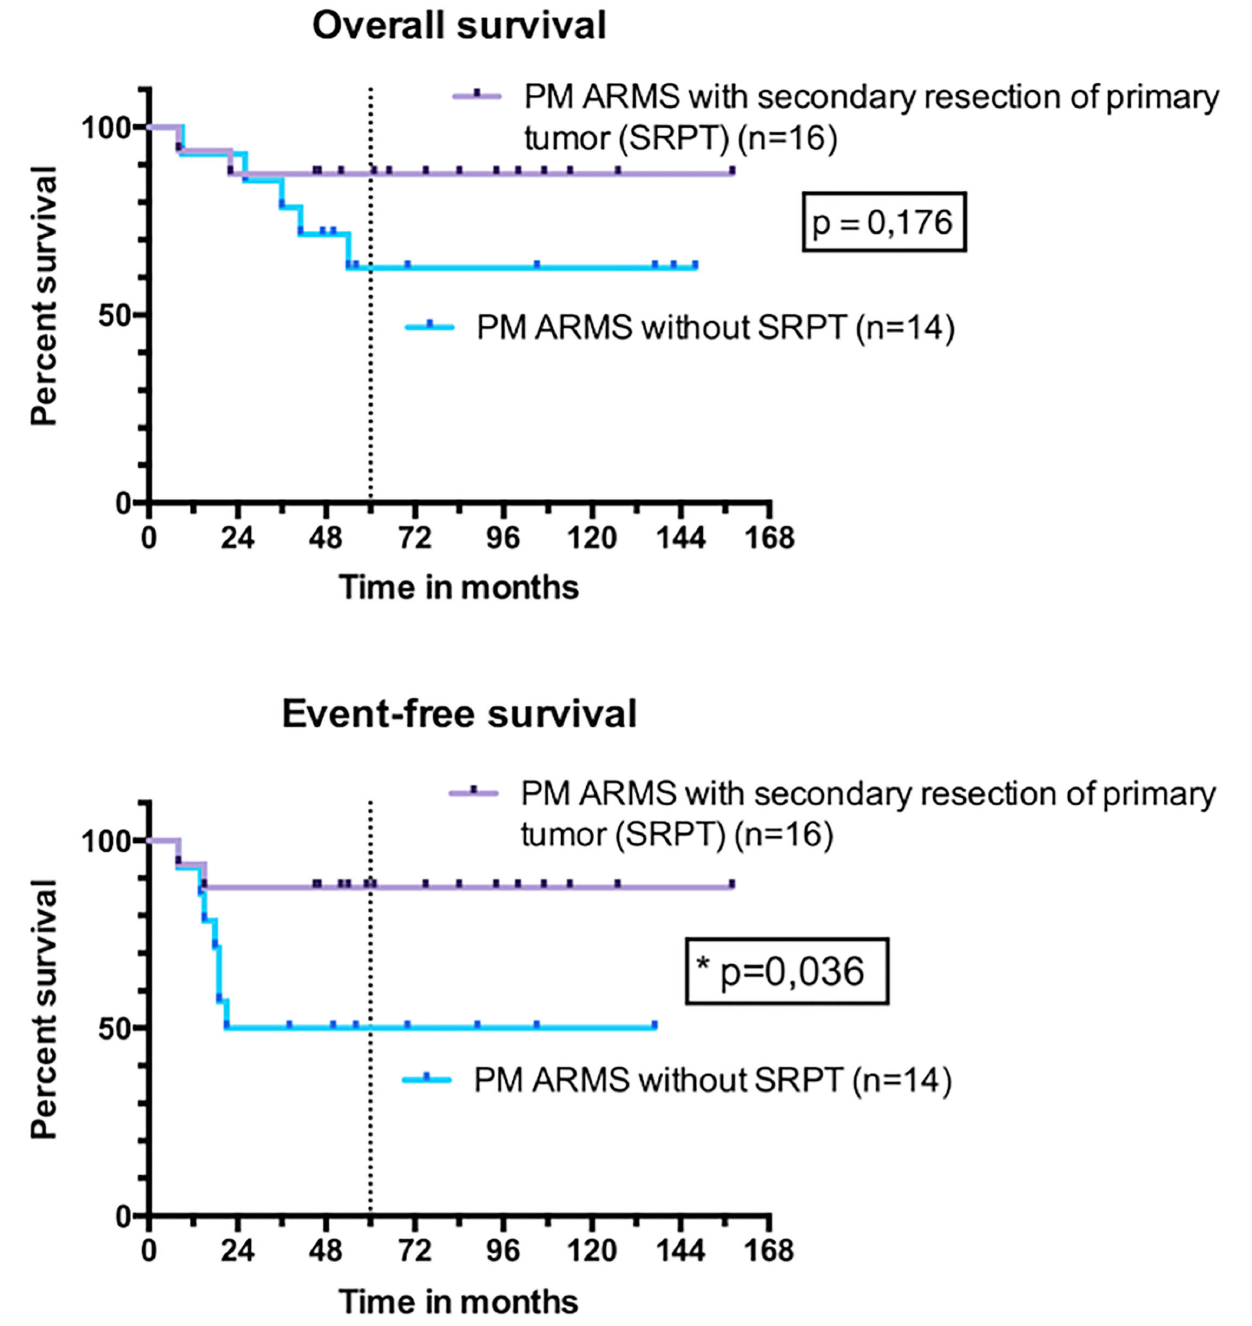
FIGURE 9 | Overall survival and event-free survival of patients with parameningeal alveolar rhabdomyosarcoma (PM ARMS) who had undergone a secondary resection of primary tumor and patients who did not.